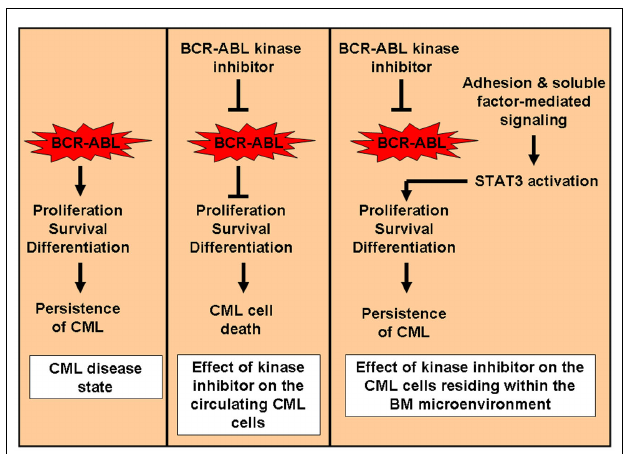
FIGURE 3 | Mechanism for persistence of CML cells in the BM microenvironment. After the acquisition of the oncogene BCR–ABL , cells are dependent on bcr–abl for proliferation, survival, and differentiation (oncogenic addiction). In circulating CML cells, shut down of the kinase activity by use of a bcr–abl kinase inhibitor results in cell death and decrease in circulating CML cell burden. However, within the BM microenvironment, CML cells do not dependent upon bcr–abl activity for survival.These cells depend on the adhesion and soluble factor-mediated signaling for survival within the BM. In this scenario, inhibition of the bcr–abl kinase activity has no effect on the survival of the CML cells leading to the persistence of disease within the BM (minimal residual